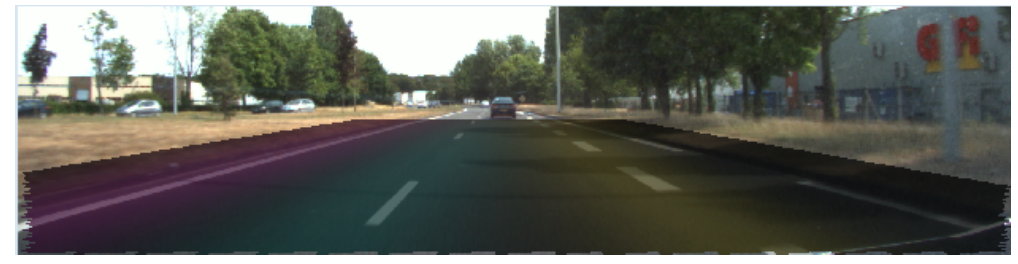
Figure 15. Resultant grids of evidential approach, large position uncertainty ( σ x = 0.9 m, σ y = 1.1 m, σ θ = 0.1 radians )